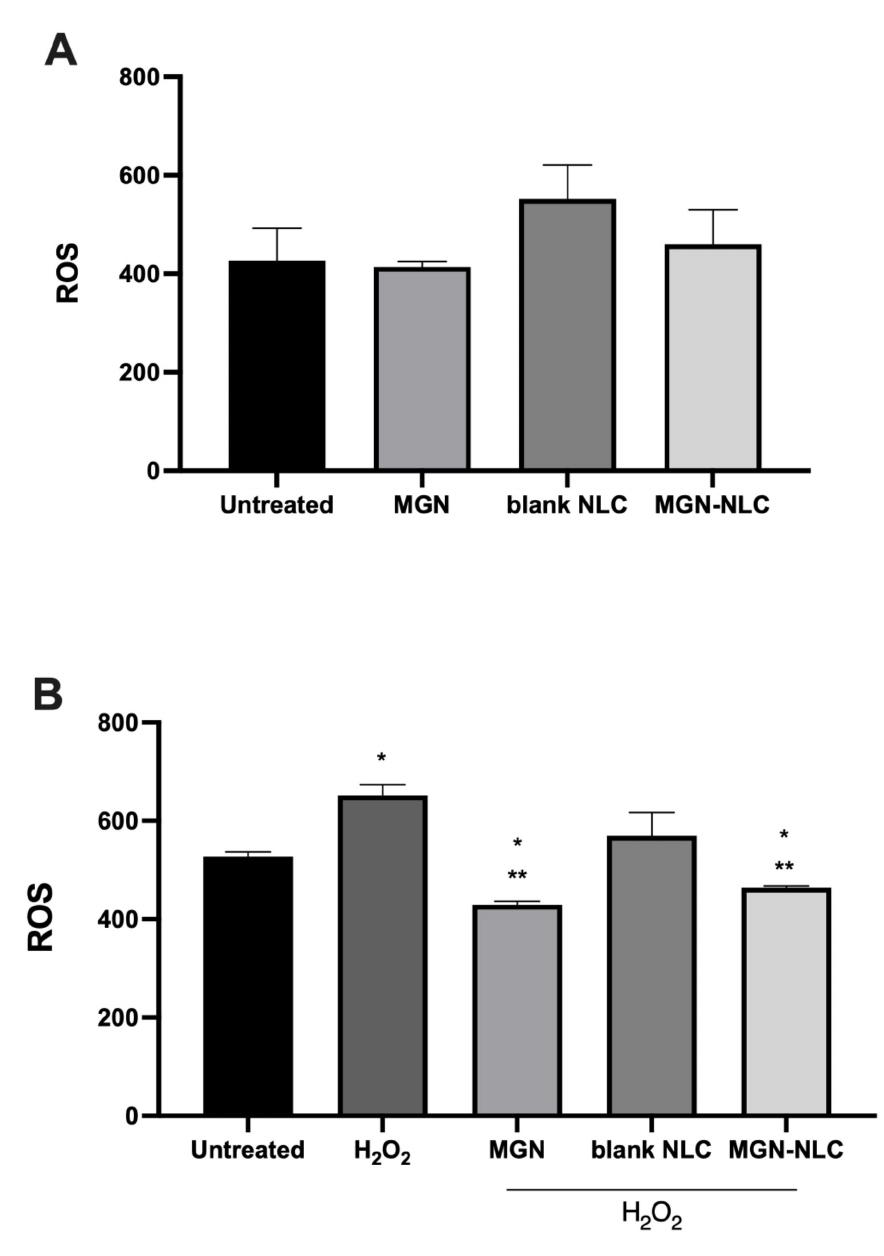
Figure 7. ROS production in ARPE-19, as measured by a simple cell assay using 2 (cid:48) ,7 (cid:48) - Dichloroflu- orescein diacetate (DCFH-DA). ( A ) ROS production in untreated cells and after treatments with 20 mg/mL MGN (standard mangiferin), blank NLC 20 µ L/mL (empty nanoparticles) and 20 µ L/mL MGN–NLC (standard MGN 20 mg/mL). ( B ) Cells were treated with hydrogen peroxide (H 2 O 2 ) at a concentration of 0.5 mM. After 30 min, the solution containing hydrogen peroxide was removed, fresh medium was added to each well and treatments with 20 mg/mL MGN (standard mangiferin), blank NLC 20 µ L/mL (empty nanoparticles) and 20 µ L/mL MGN–NLC (standard MGN 20 mg/mL) were performed. * p < 0.05 versus untreated; ** p < 0.05 versus H 2 O 2